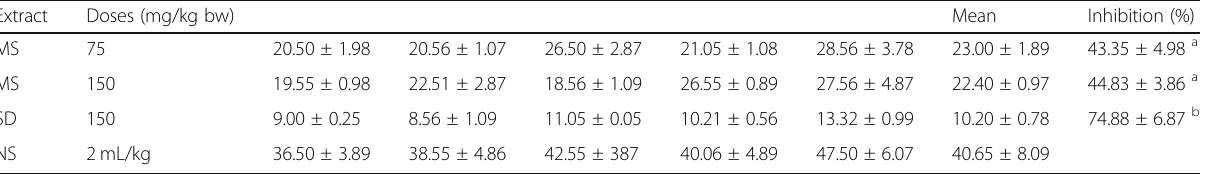
Table 4 Effect of purified fraction of M. senegalensis leaf on abdominal constrictions in mice Extract Doses (mg/kg